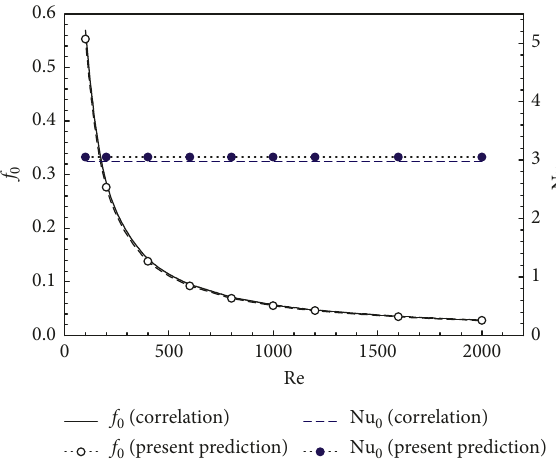
Figure 2: Validation of the smooth channel on Nusselt number and friction